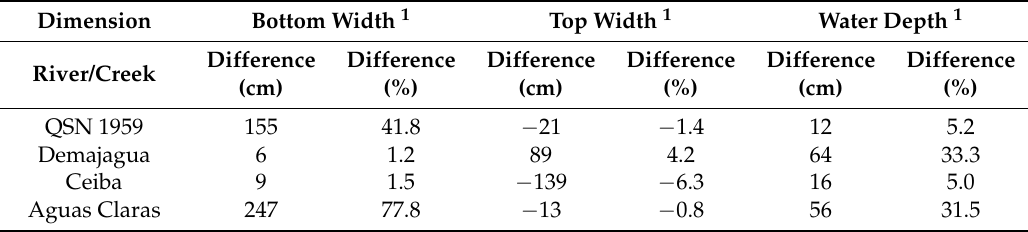
Table 4. Differences between the field-surveyed and LiDAR cross-sections for each watershed. Dimension Bottom Width 1 Top Width 1 Water Depth 1 Difference Difference Difference Difference Difference Difference River/Creek (cm) (%) (cm) (%) (cm) QSN 1959